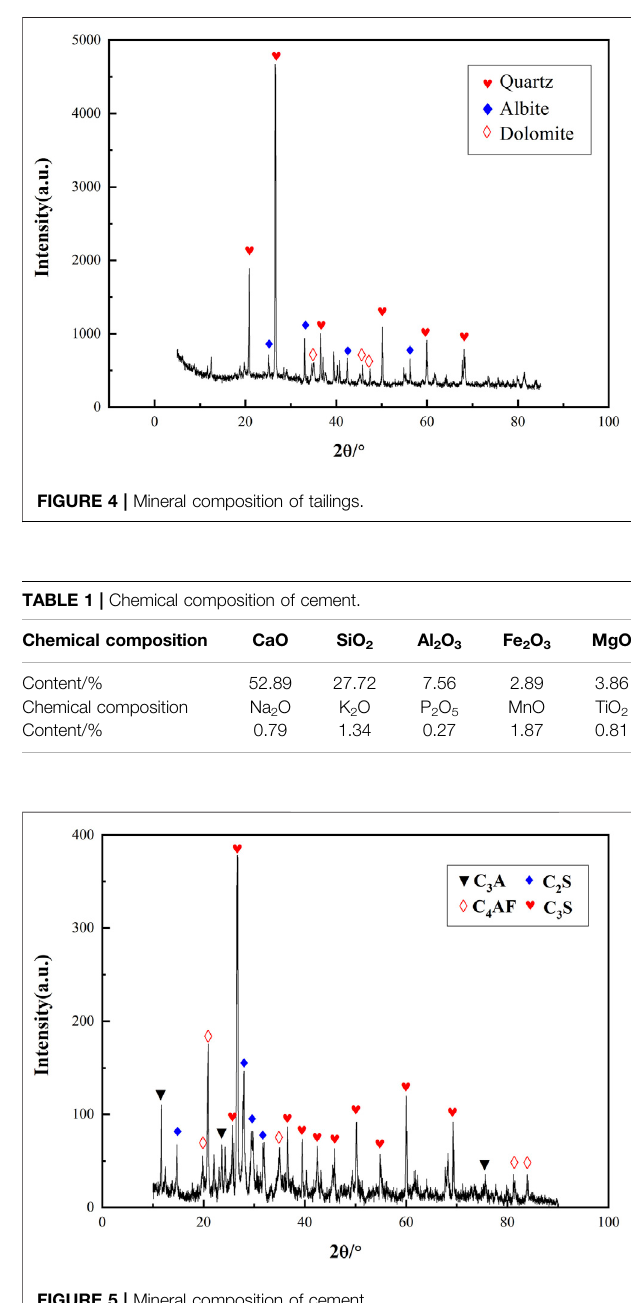
FIGURE 5 | Mineral composition of